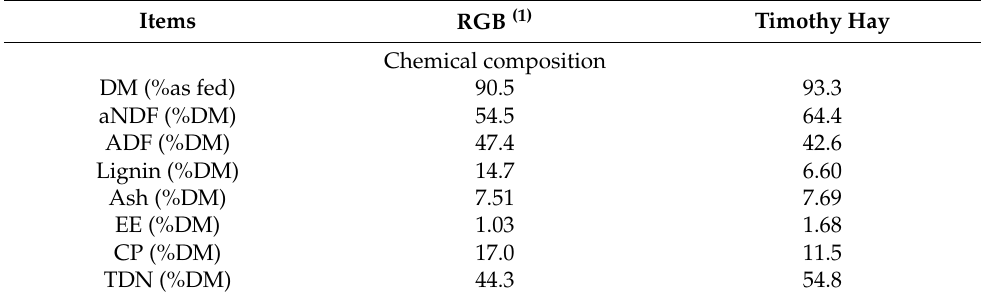
DM, dry matter; aNDF, neutral detergent fiber analyzed with heat-stable α -amylase; ADF, acid detergent fiber;